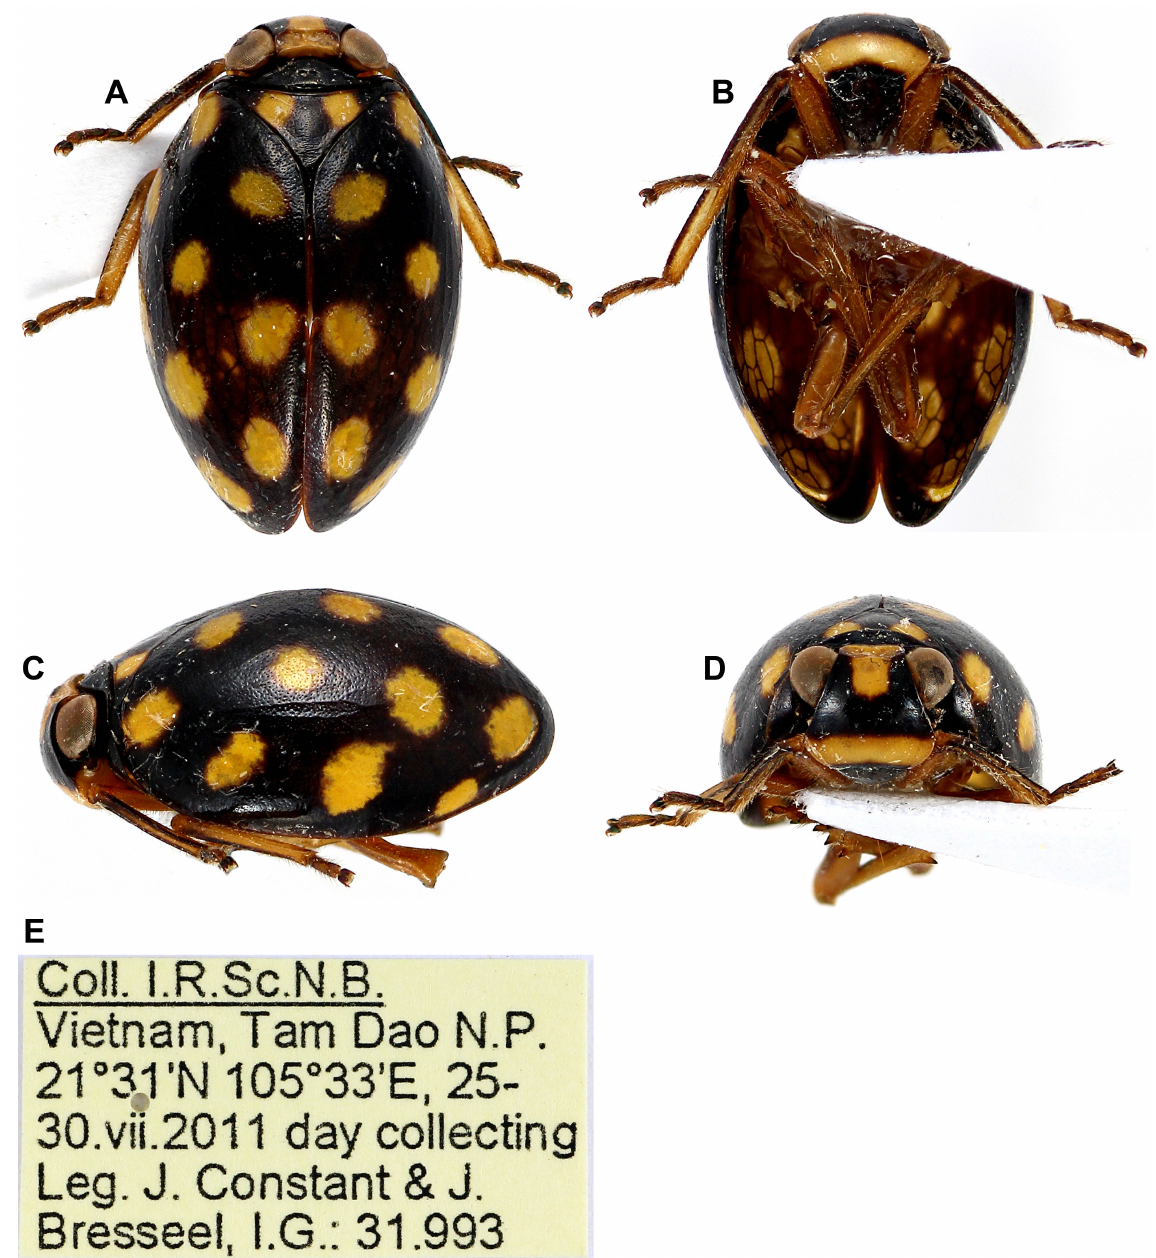
Fig. 5. Gergithus (Maculergithus) tamdao subgen. et sp. nov., holotype, ♂, total length: 6.0 mm. A . Habitus, dorsal view. B . Habitus, ventral view. C . Habitus, lateral view. D . Habitus, frontal view. E .